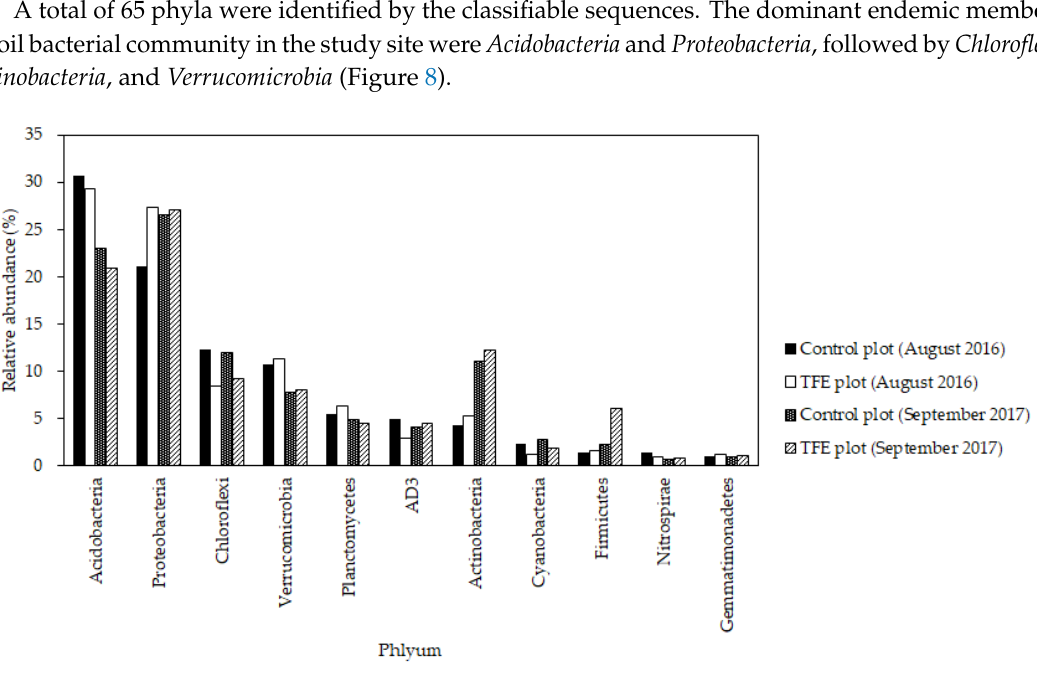
Figure 9. Root collar diameter increment of Korean pine saplings in the control and TFE plots with standard error (error bars). Different Latin letters indicate significantly different between control and TFE plots within each measuring day ( p < 0.05). ( n = 15 for control plots, n = 19 for TFE plots).